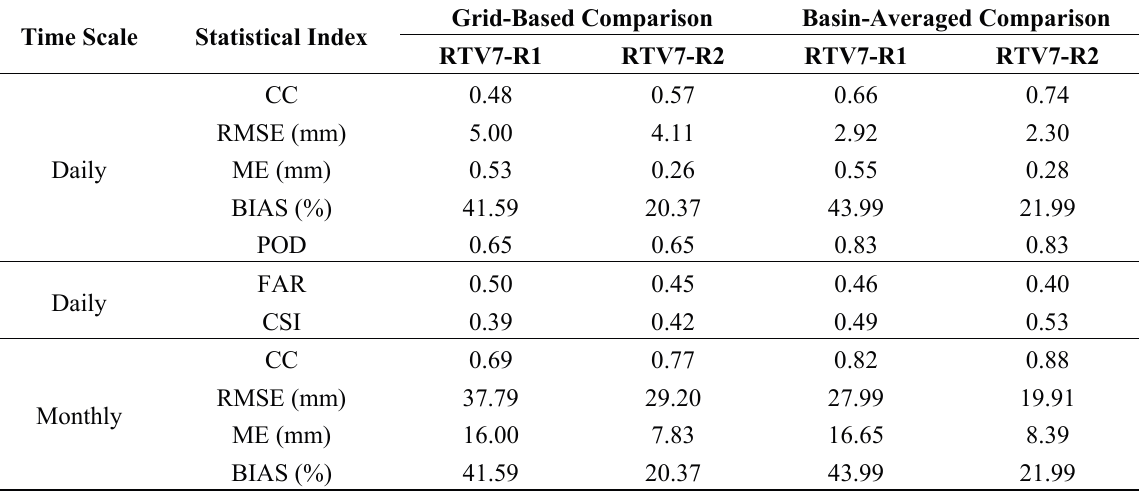
Table 1. Statistical summary of two TMPA-RT precipitation estimates (RTV7-R1 and RTV7-R2) versus gauge observation at daily and monthly scales for grid-based and basin-averaged comparisons, respectively a